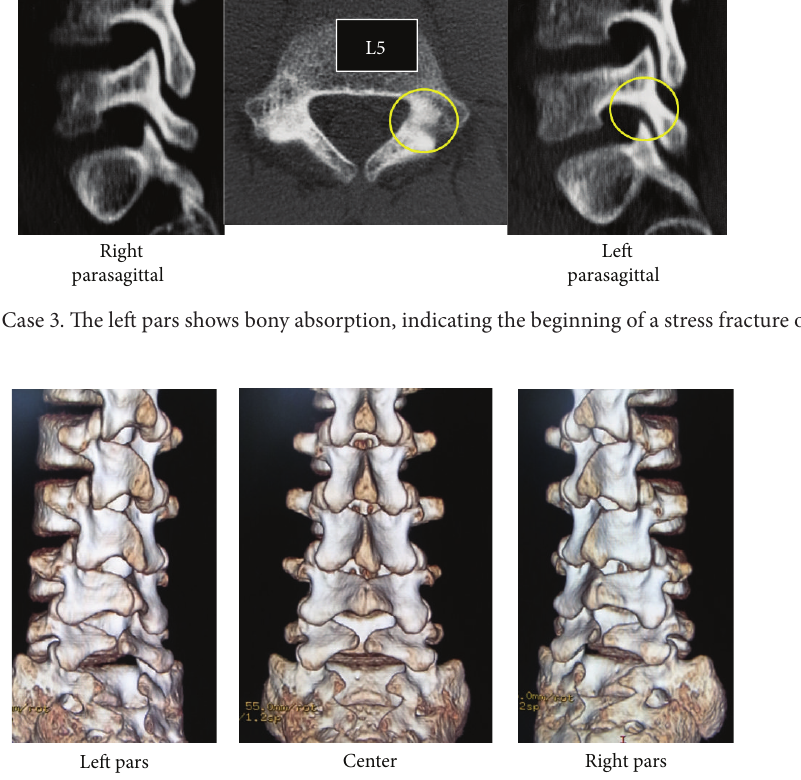
Figure 9: 3D-CT of Case 3. Note the concomitant SBO.